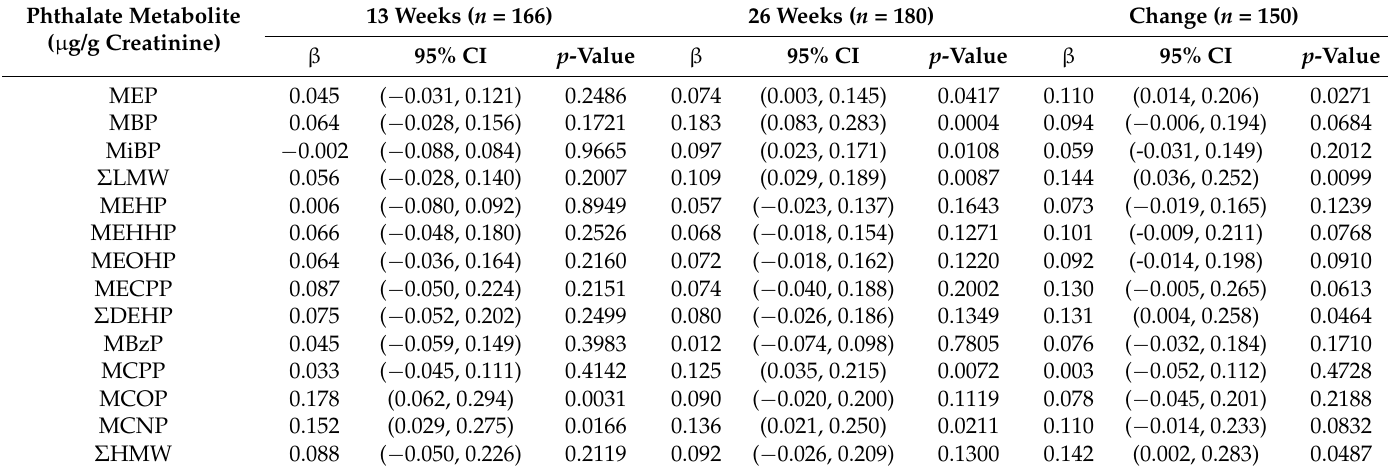
Table 3. Regression models of phthalate metabolite concentrations with isoprostane levels at 13 and 26 weeks gestation a